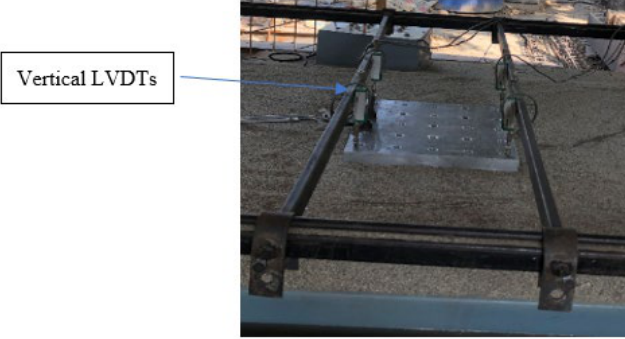
Figure 9. Arrangement for vertical LVDTs.